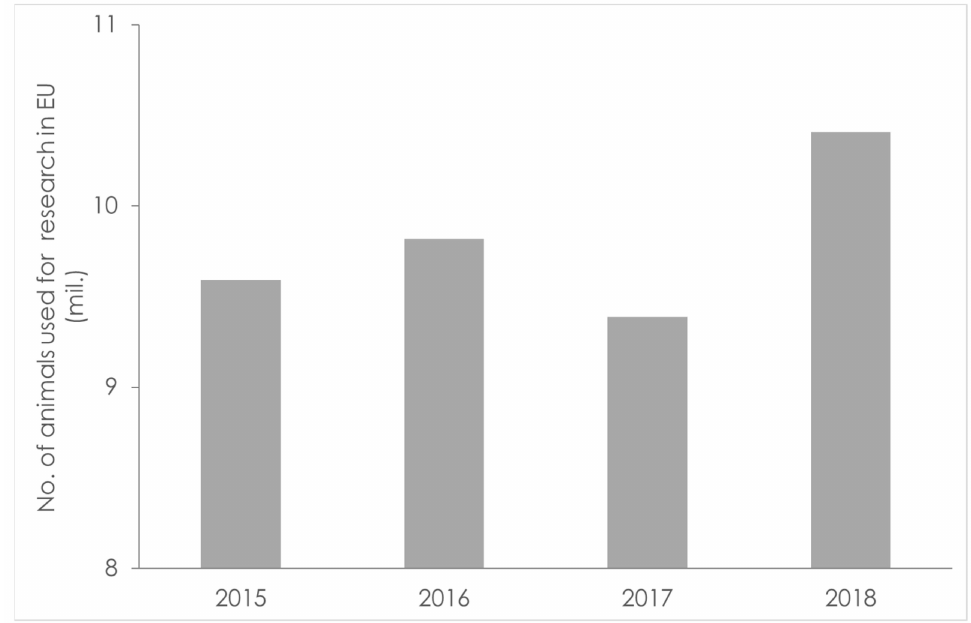
Figure 2. The numbers of animals used for research and testing in the EU in the period 2015–2018